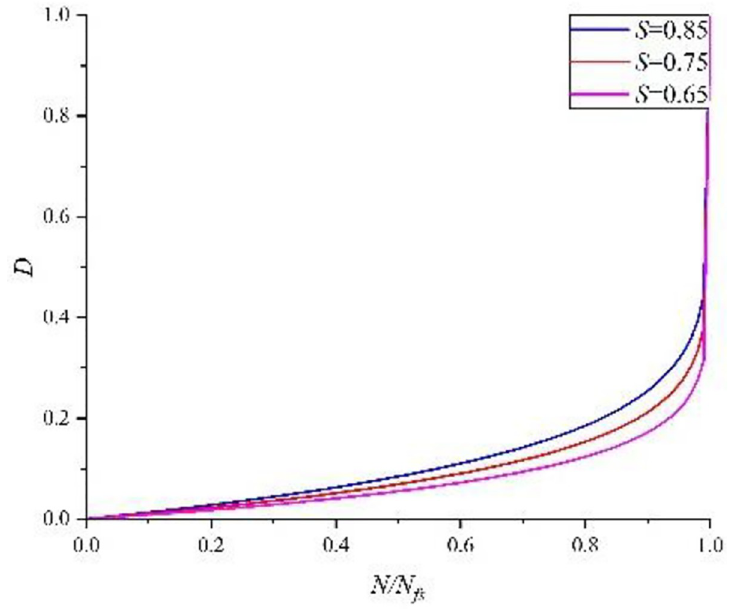
Fig 7. Fitting curve of relative damage strength at different stress